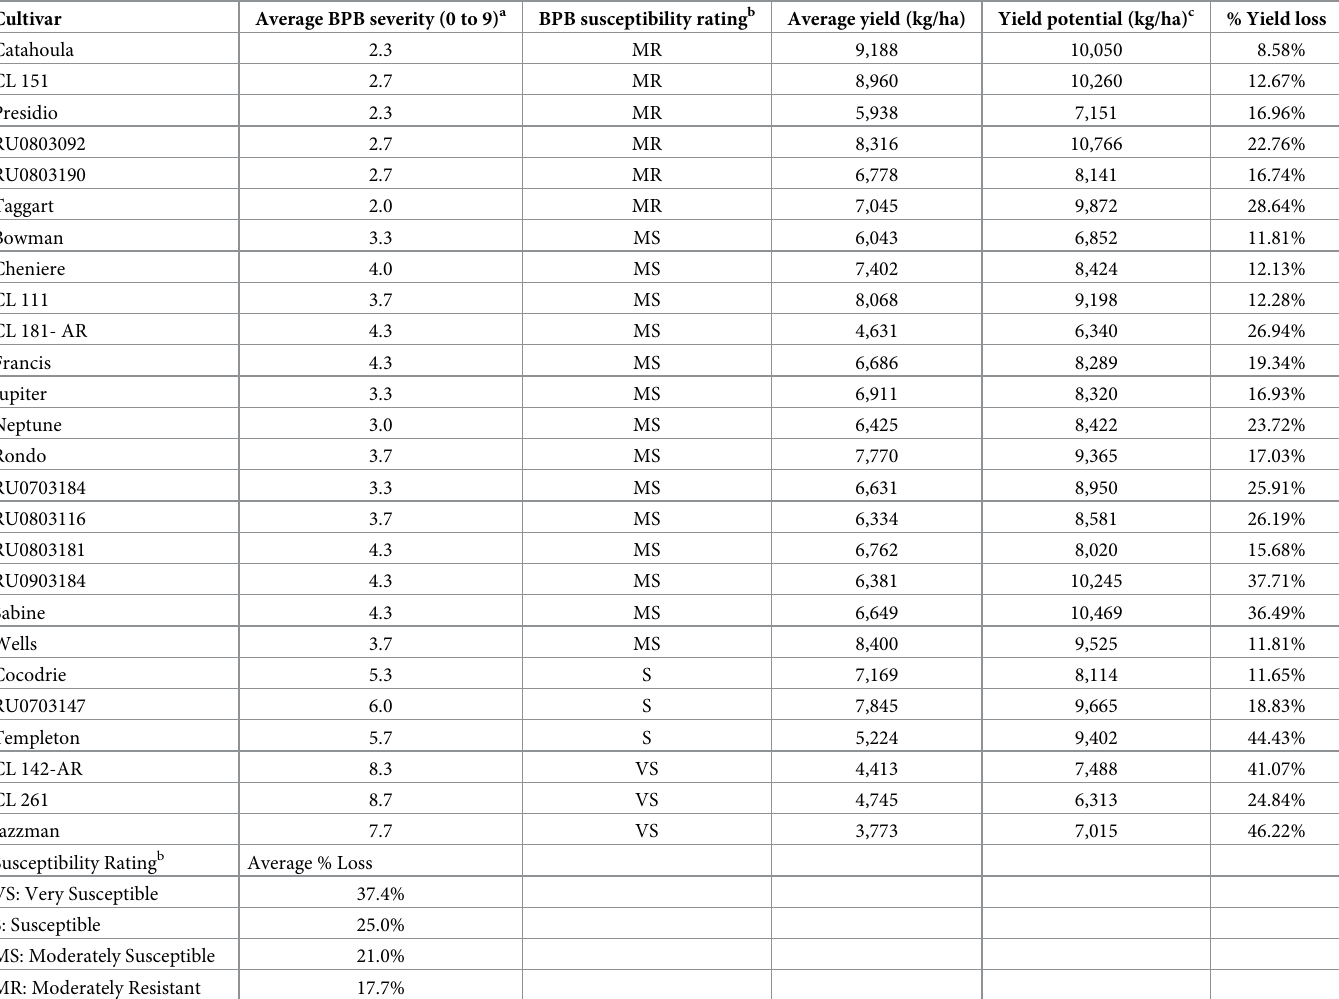
Table 1. Susceptibility to Bacterial Panicle Blight, average rice yields, and estimated yield loss due to Bacterial Panicle Blight by variety in field trials.